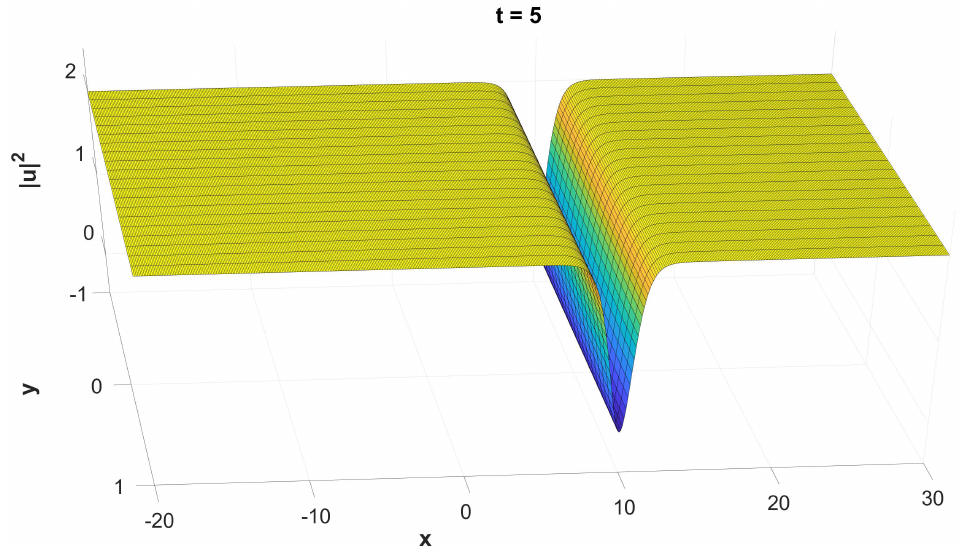
(cid:12) (cid:12) u ( x , y , t = 5 )